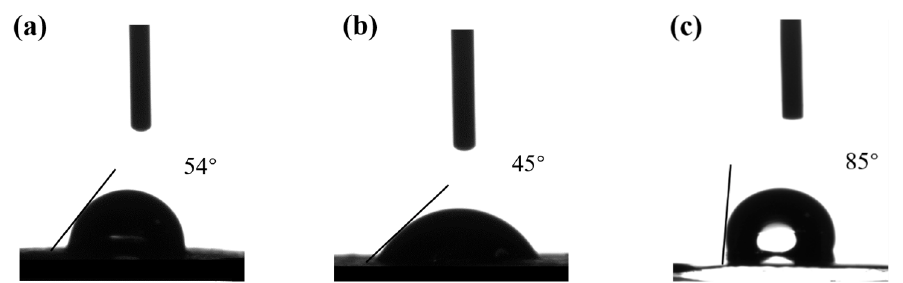
Figure 7. ( a ) is the contact angle between FWF15-CNF5 paper-based electrodes and electrolyte. ( b ) is the contact angle between FWF15-BNF5 paper-based electrodes and electrolyte. ( c ) is the contact angle between commercial LFP electrode and electrolyte.